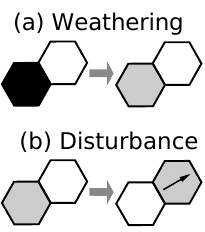
Figure 7. Transitions representing rock-to-regolith transformation by weathering (a) and regolith disturbance (b) , in which a stationary particle becomes mobile and switches position with a air cell. The illustration represents one of the six possible